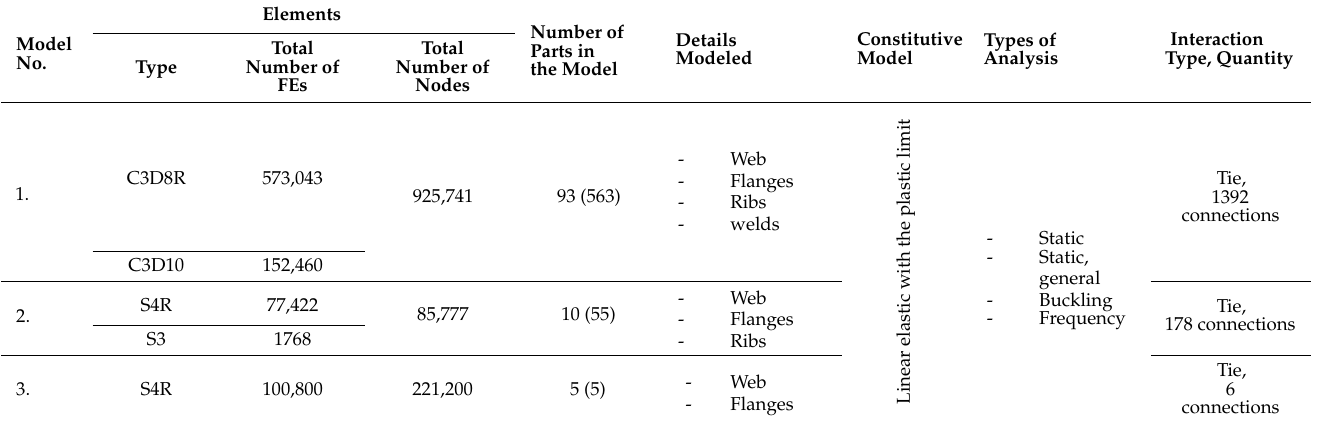
Table 3. Details of the full-scale FEM